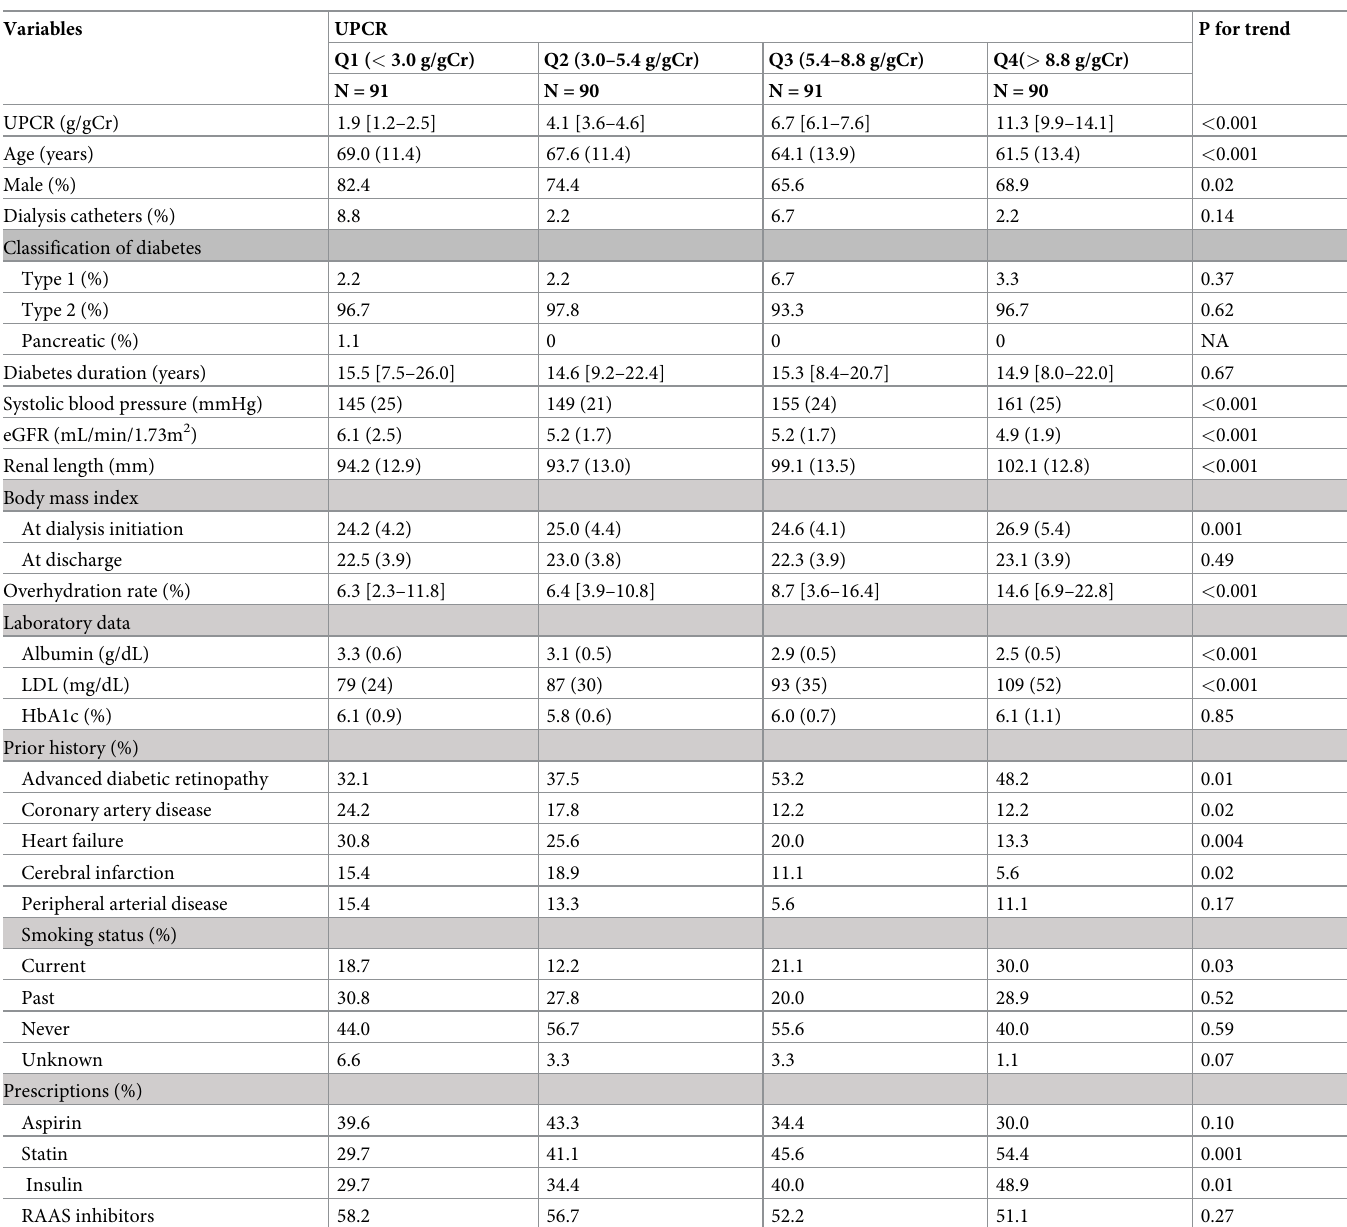
Table 1. Baseline